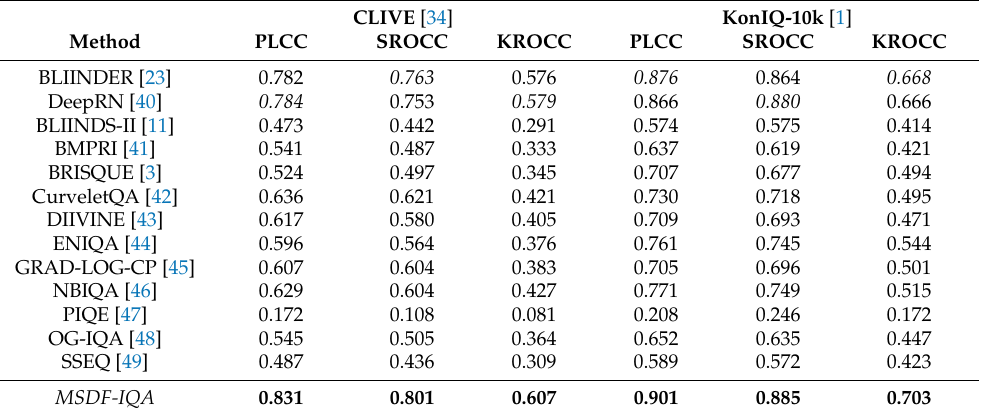
Table 7. Comparison of MSDF-IQA to the state-of-the-art on authentic distortions (CLIVE [34] and KonIQ-10k [1]). Median PLCC, SROCC, and KROCC values were measured over 100 random train–test splits. Best results are typed in bold, and second best results are typed in italic.